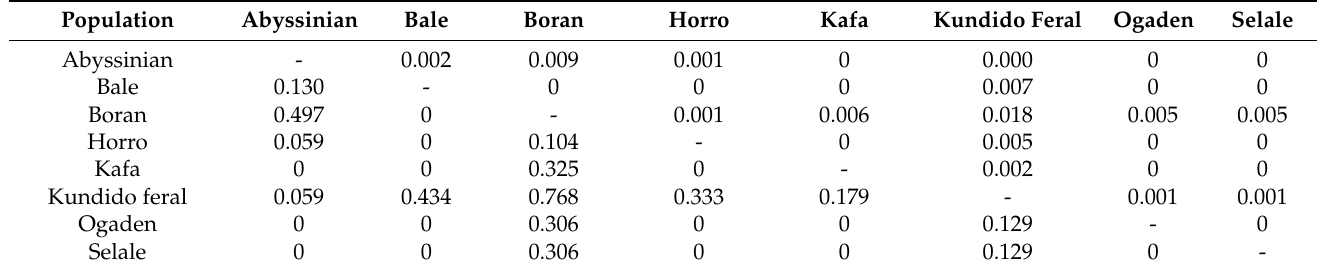
Table 5. Matrix of pair-wise Hudson et al. (1992b) F ST (below diagonal) and D A distances (D-loop nucleotide sequence divergences, above diagonal) between seven domestic and one feral Ethiopian horse